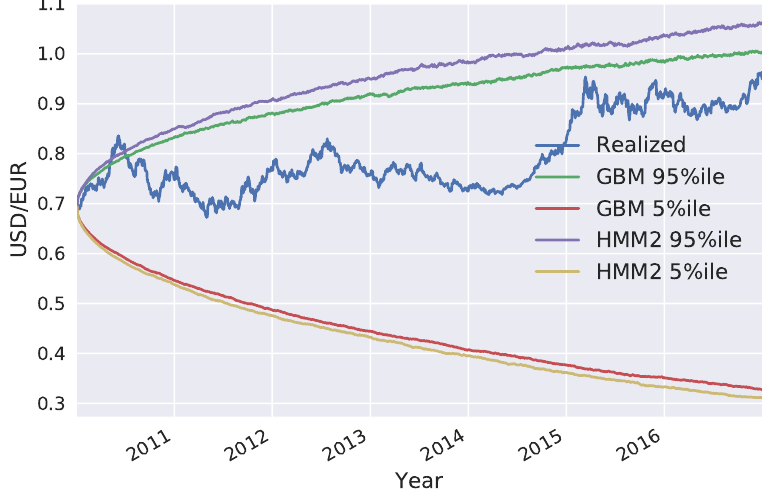
Figure 7. Percentiles of long-term distribution cones for USD/EUR under GBM and HMM with two